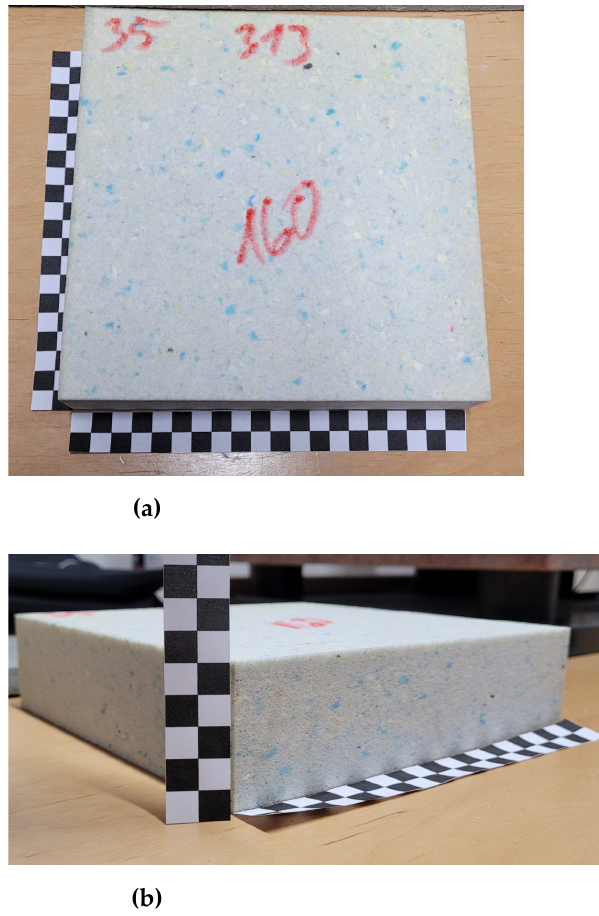
Figure 4. An example of tested samples of rebound polyurethane foam: ( a ) top view; ( b ) side view. One tile on the tile scale is 10 mm × 10 mm (own elaboration).